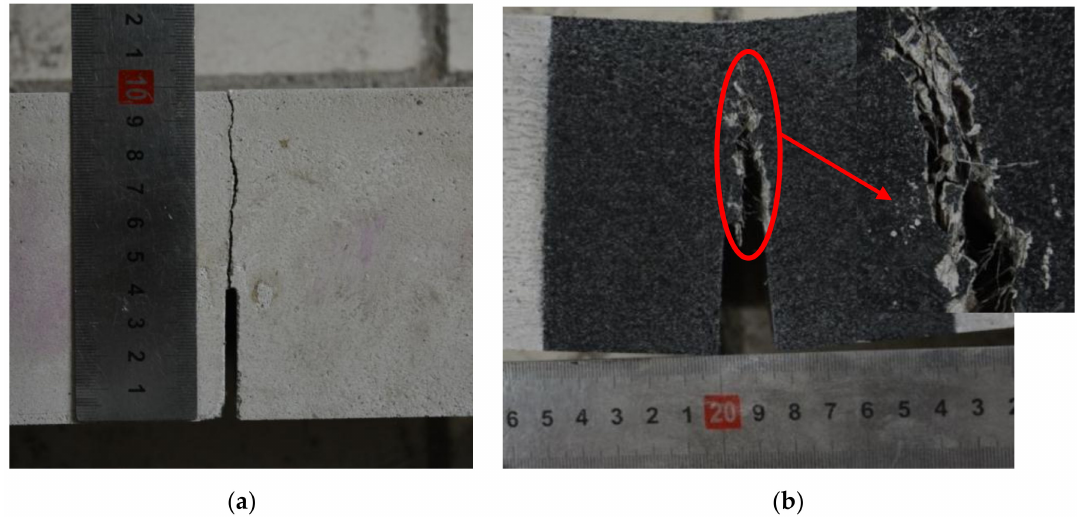
Figure 3. Failure modes of plain and steel fiber-reinforced SGM. ( a ) Plain SGM; ( b ) Steel fiber-reinforced